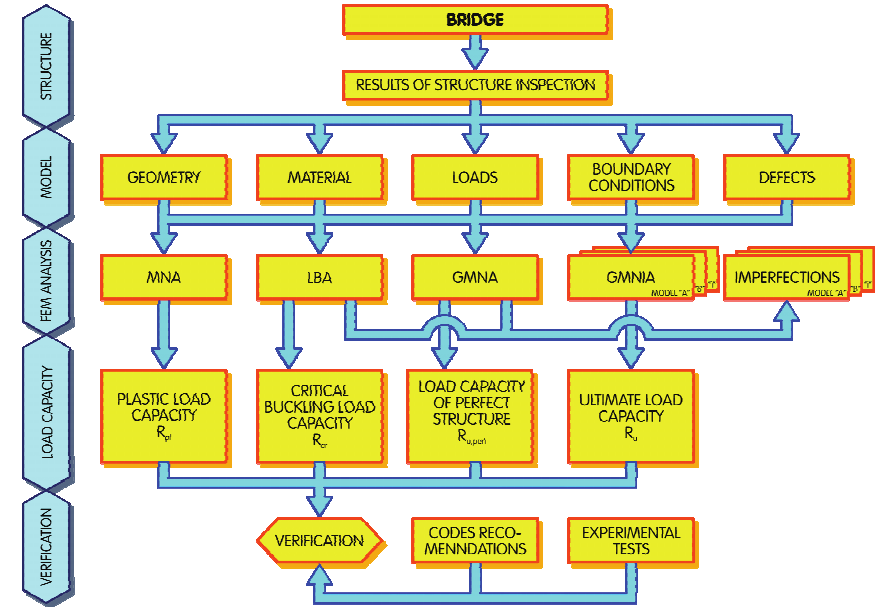
Fig. 3. Procedure for assessing ultimate shear capacity of plate girders with initial defects, using full GMNIA (Ku ż awa